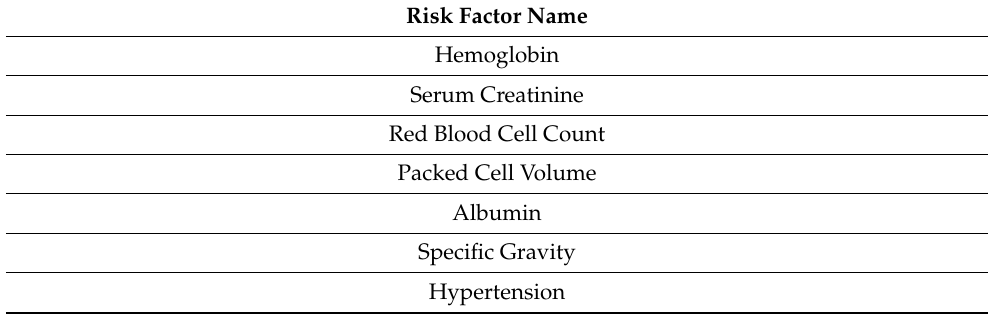
Table 7. The most critical risk factors from CKD data. Figure 10. Accuracy graphical representation for the UCI CKD data set.